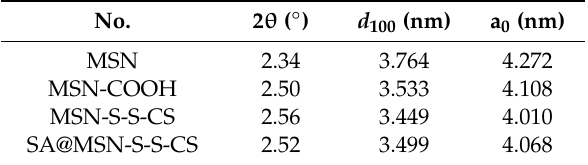
Table 2. Crystallographic parameters of the MSN and its composites.